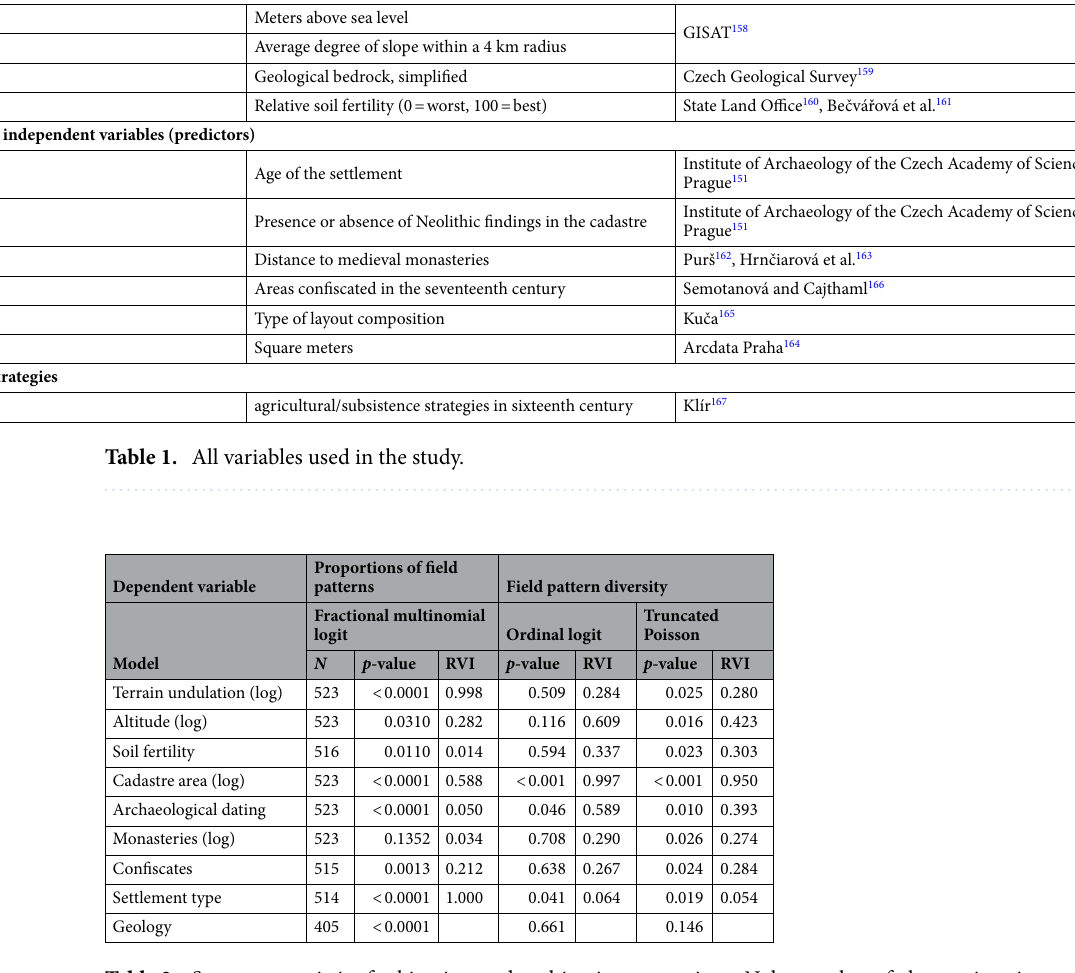
According to Table 2, the most significant variables affecting the proportions of field pattern types were settlement type (RVI = 1.000), terrain undulation (RVI = 0.998), and cadastre area (RVI = 0.588). These variables affected almost all field pattern types. The influence of other variables had less impact on the overall variability. Some variables did not affect any field pattern type at all: distance to medieval monasteries (see Table 2) and ancient settlement area ( p -value from the bivariate regression is 0.092). The field pattern diversity was influenced by one variable only: the cadastre area (RVI = 0.950). Field pattern type A (segmental plužina) was associated with very rugged terrain ( p < 0.001), small cadastre area ( p < 0.001), preferably igneous but definitely non-sedimentary geological bedrock (see Fig. 3) and specific